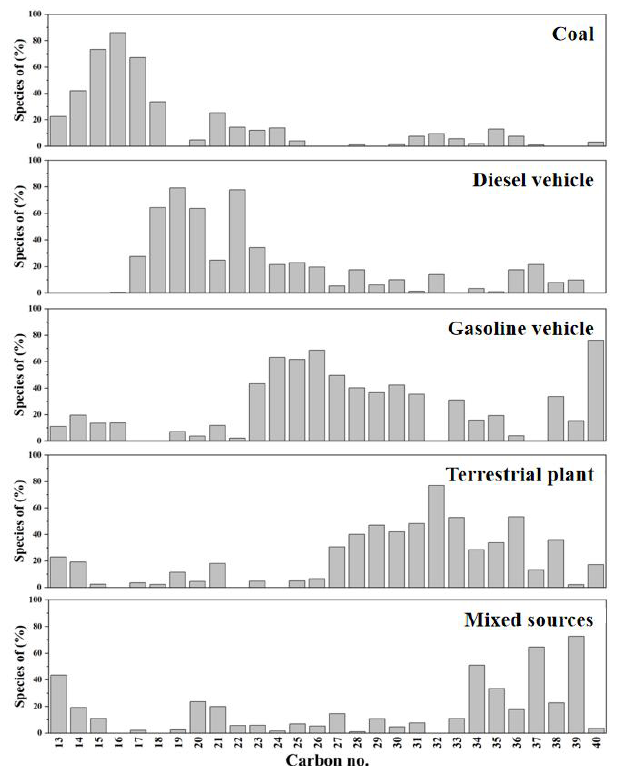
Figure 7. Proportions of the different n -alkane homologs in the factors identified by the positive matrix factorization